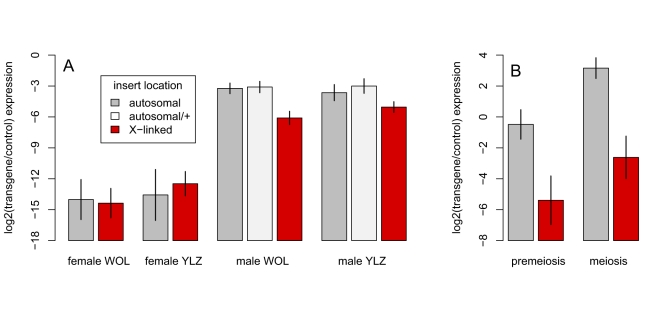
Sex, chromosome, and spermatogenic stage effects on the expression of WOL and YLZ transgenes.(A) Expression of ocn:lacZ transgenes is low or absent in females, and is significantly lower for X-linked inserts than autosomal inserts in males. Bars indicate the mean expression measured from 8 X-linked and 8 autosomal WOL inserts and 6 X-linked and 5 autosomal YLZ inserts. RNA was extracted from whole adult flies and expression from autosomal inserts was measured in both heterozygous and homozygous male and homozygous female genotypes. (B) The difference between X-linked and autosomal inserts persists from premeiotic to meiotic cells in the male germline. A subset of genotypes (two X-linked and one autosomal WOL and two X-linked and one autosomal YLZ) shown in panel A were used for dissections (see Materials and Methods for details). In both panels, gene expression is measured relative to a Rpl32 control probe and error bars indicate 95% confidence intervals.